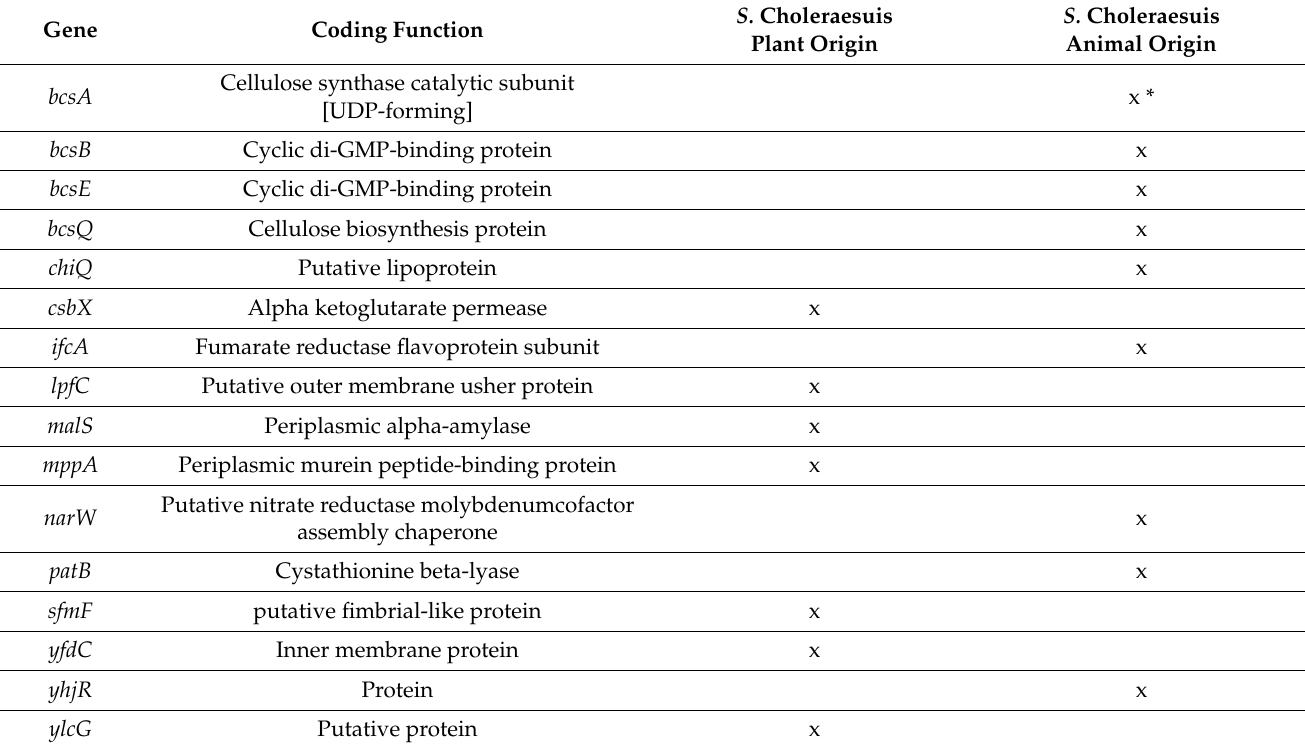
Table 1. Genes identified only in one of the analyzed Salmonella Choleraesuis strains by means of Roary and their function. Gene Coding